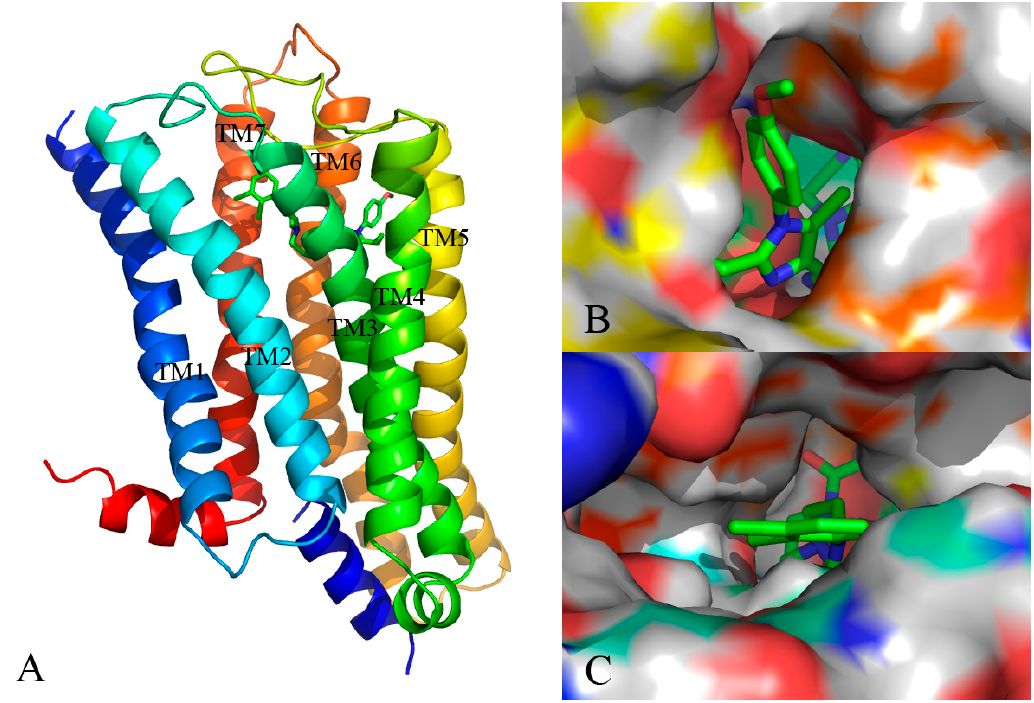
Figure 6. ( A ) The binding pattern of compound 13 and protein; ( B , C ) Surface structure depicted with pocket depth potential of the active site within the